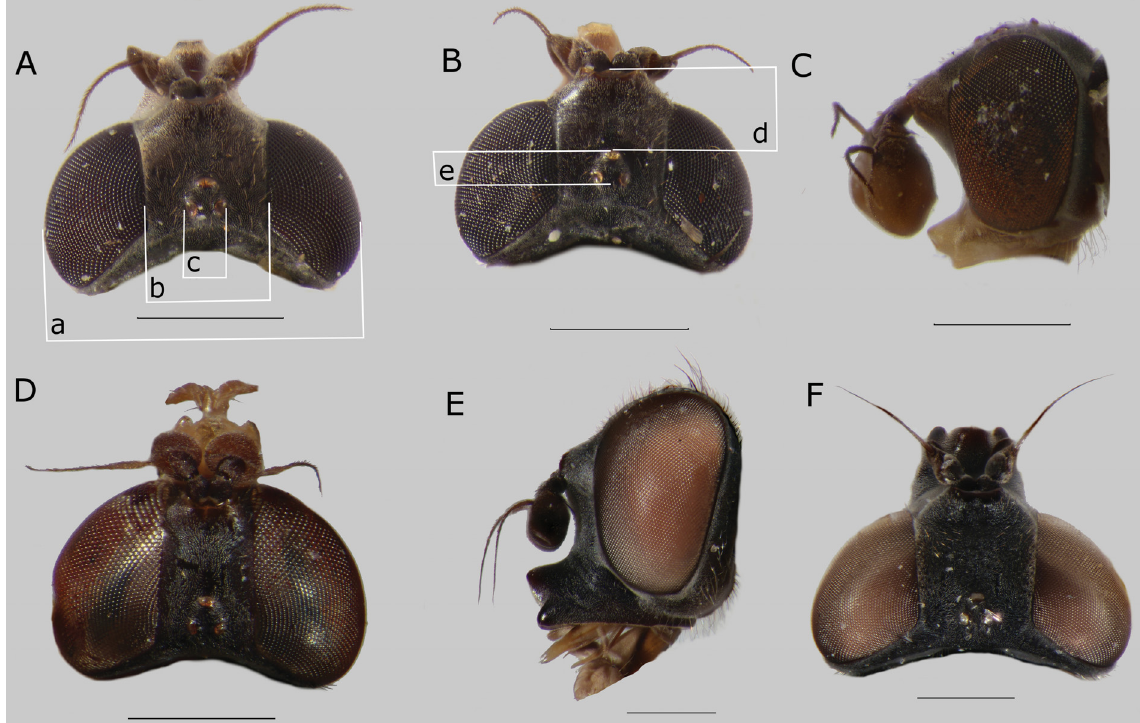
Fig. 3. Head, lateral view (C, E), and dorsal view (A–B, D, F). A . Sphegina (Sphegina) abbreviata sp. nov., paratype, ♀ , Nepal. B . S. (S.) angustata sp. nov., paratype, ♀ , Nepal. C . S. (S.) angustata Ren, 2006, ♀ , China. Abbreviations: a = width of head; b = width of vertex; c = width of ocellar triangle; d = length of frons; e = length of ocellar triangle. Scale bars = 0.5